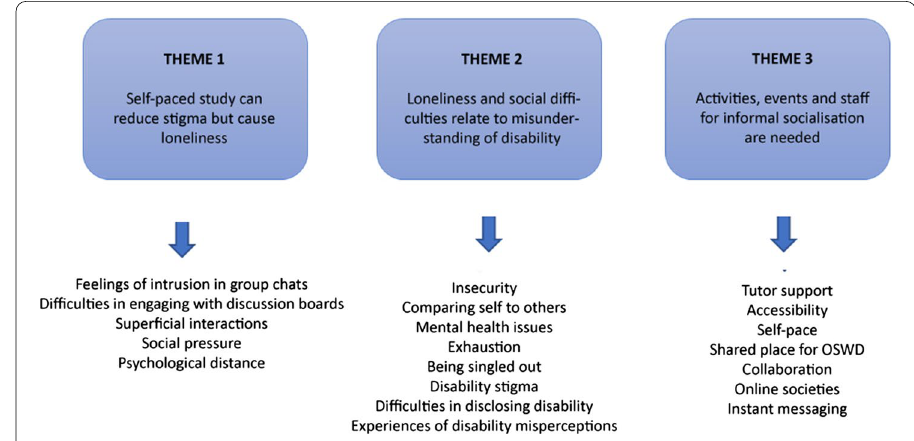
Fig. 1 Organising codes into themes via mind